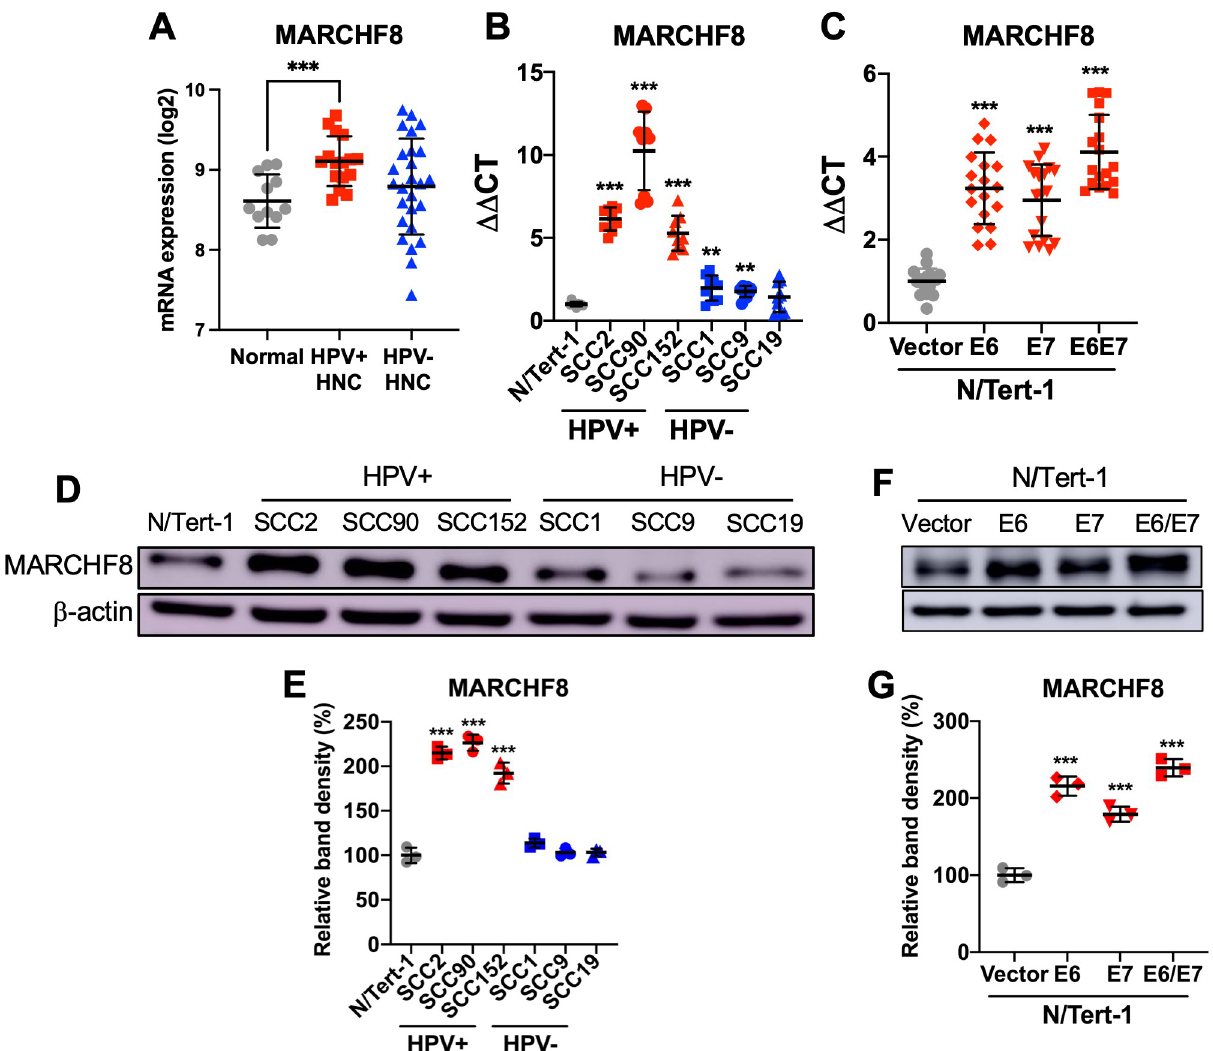
Fig 1. MARCHF8 expression is upregulated in HPV+ HNC. MARCHF8 mRNA expression levels in microdissected human tissue samples from HPV + ( n = 16) and HPV- ( n = 26) HNC patients, and normal individuals ( n = 12) were analyzed using our previous gene expression data (GSE6791) [28] and shown as fluorescence intensity (log2) ( A ). The MARCHF8 mRNA expression was validated in normal (N/Tert-1), HPV+ HNC (SCC2, SCC90, and SCC152), and HPV- HNC (SCC1, SCC9, and SCC19) cells ( B ) by RT-qPCR. MARCHF8 mRNA levels were determined in N/Tert-1 cells expressing E6 and/or E7 by RT-qPCR ( C ). The data shown are ΔΔ CT values normalized by the GAPDH mRNA level as an internal control. MARCHF8 protein levels were determined in HPV+ and HPV- HNC cells ( D and E ) and N/Tert-1 cells expressing HPV16 E6, E7, or E6 and E7 ( F and G ) by western blotting. β - actin was used as a loading control. The relative band density was quantified using the NIH ImageJ program ( E and G ). All experiments were repeated at least three times, and the data shown are means ± SD. P values were determined by Student’s t -test. � p < 0.05, �� p < 0.01, ��� p < 0.001.